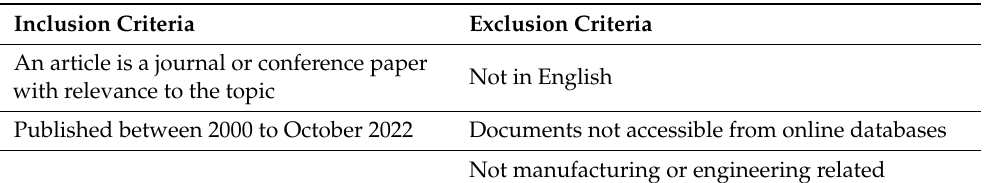
Table 1. Inclusion and exclusion criteria of the database